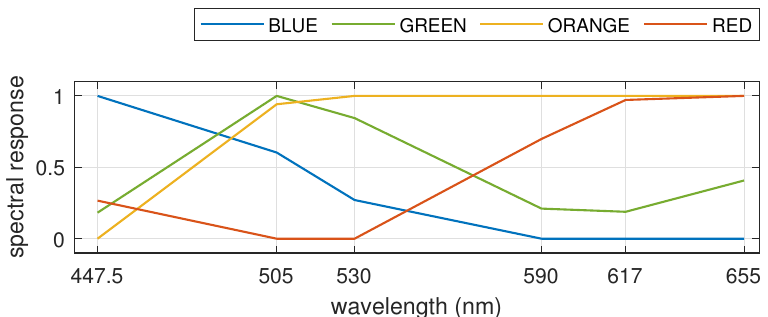
Figure 10. Normalized spectral response of the four colored elements in the Windows logo plotted against the center wavelengths of LEDs in the multispectral light source.